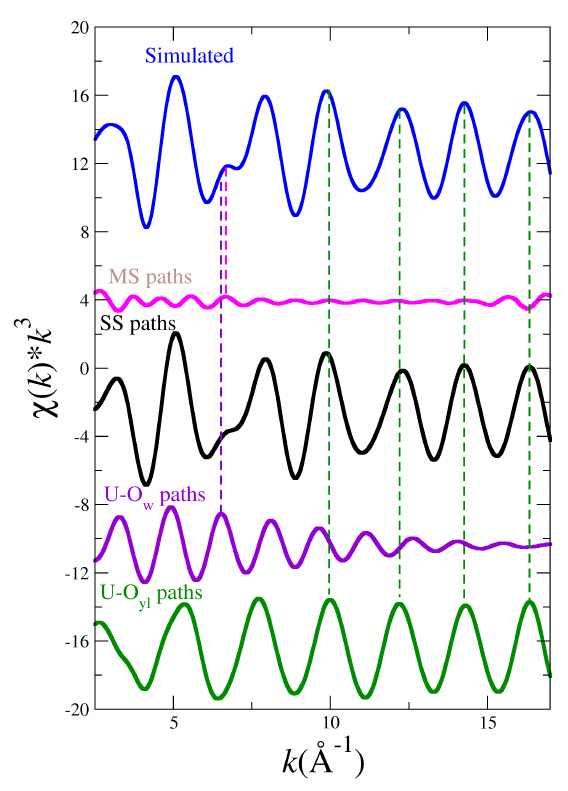
Figure 5. Simulated L III -edge k 2 -weighted EXAFS spectrum for U(VI) (blue line) and its decomposition in MS scattering (pink line) and SS scattering (black line) contributions, as well as the U-O w (magenta line) and U-O yl (green line) SS